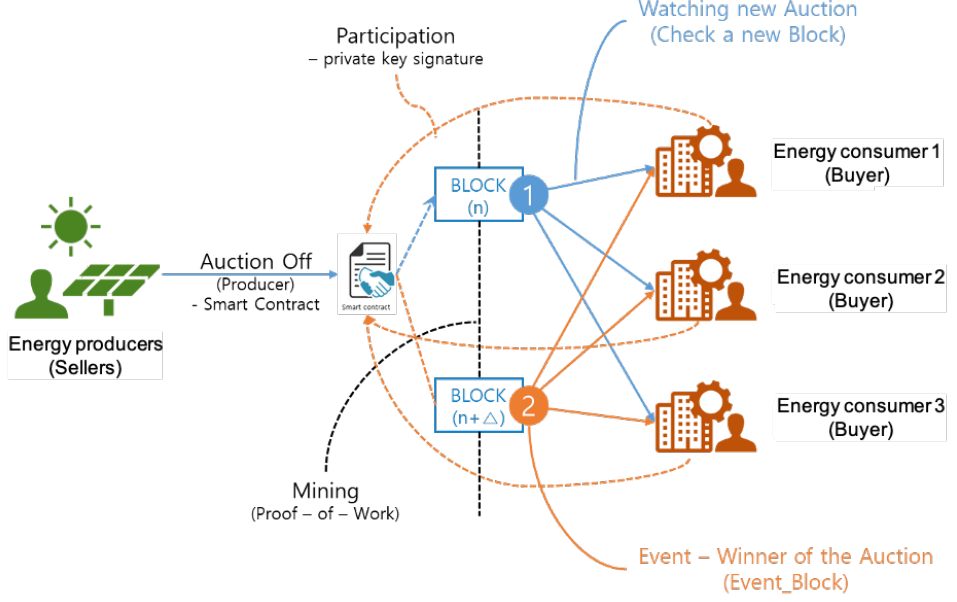
Figure 2. Auction-based energy transaction